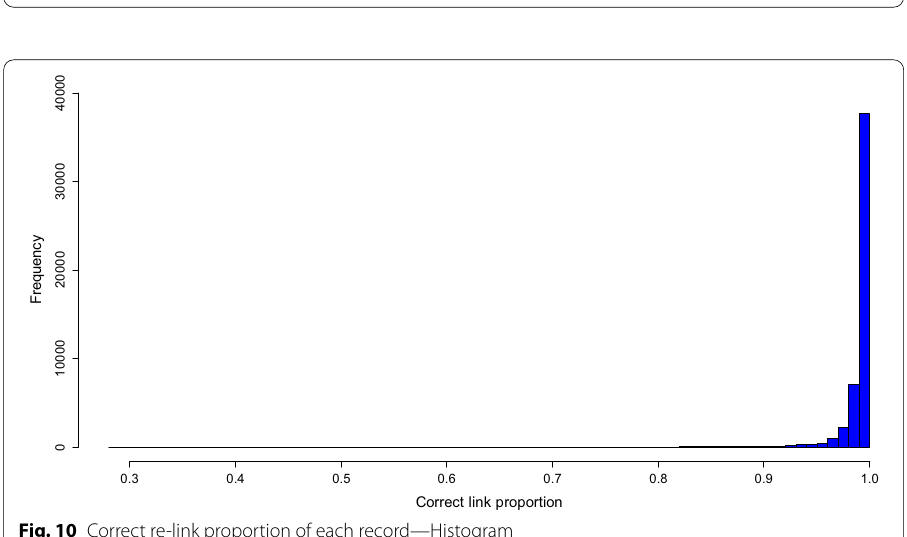
Fig. 9 Correct re-link proportion of each record—Density plot